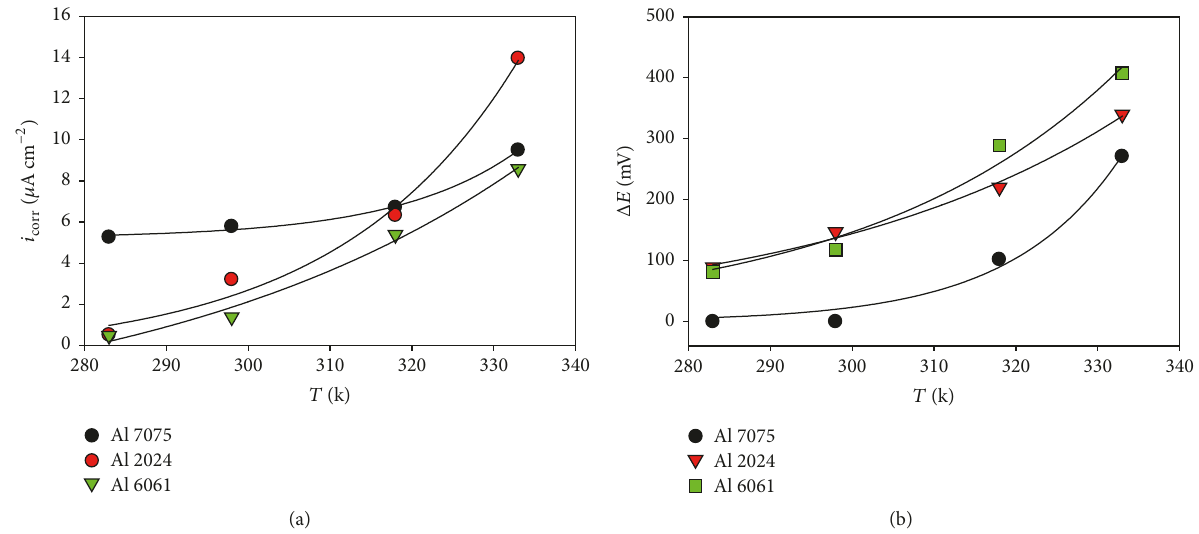
Figure 11: Dependence of (a) 𝑖 corr and (b) Δ𝐸 of Al alloys in the Red Sea water on temperature.